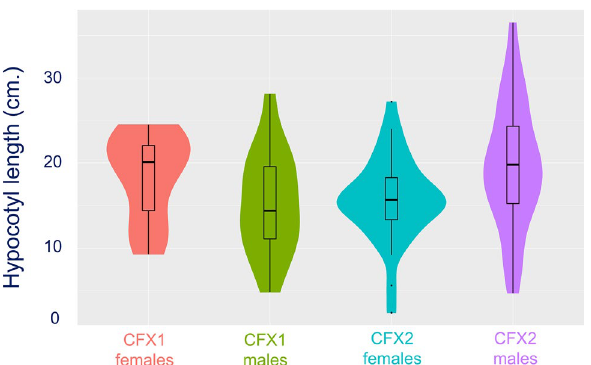
Figure 1. Morphological differences between two-week old male and female (hermaphrodite) plants for hypocotyl length. This violin plot represents the distribution of the phenotypes; their medians are indicated by the thick black line, their interquartile ranges are represented by the black rectangle and the distribution is shown by the coloured